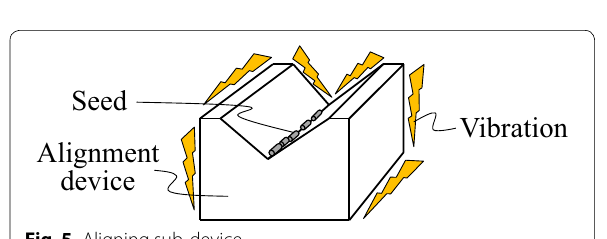
Fig. 5 Aligning sub-device Fig. 6 Overview of the remote radioactive seed-loading